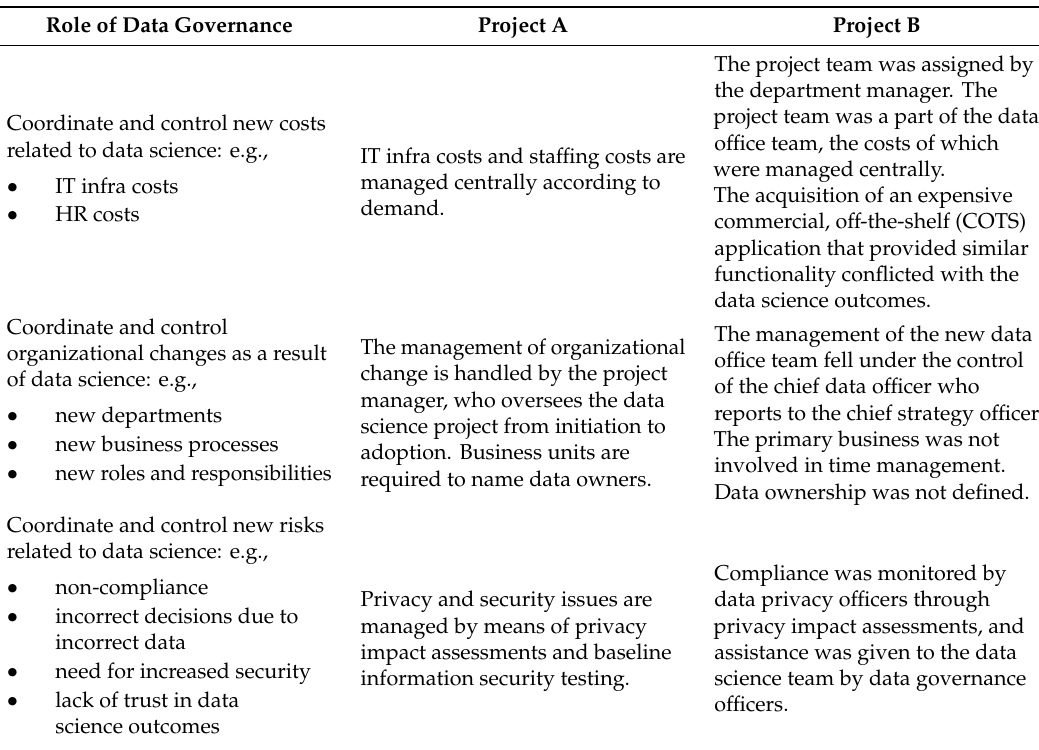
Table 6. Comparison of the cases with regards to the role of data governance in coordinating and controlling organizational consequences of data